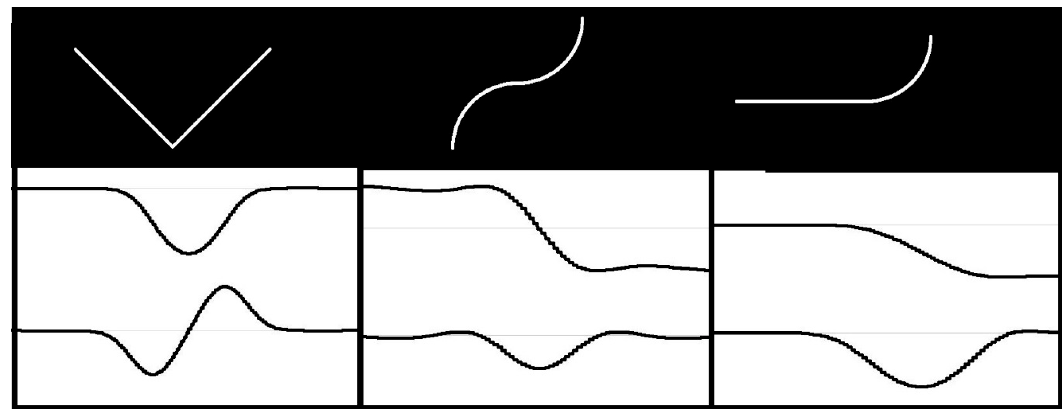
Figure 4. Typical feature points and corresponding signature plots (upper plot: curvature, lower plot: derivative).